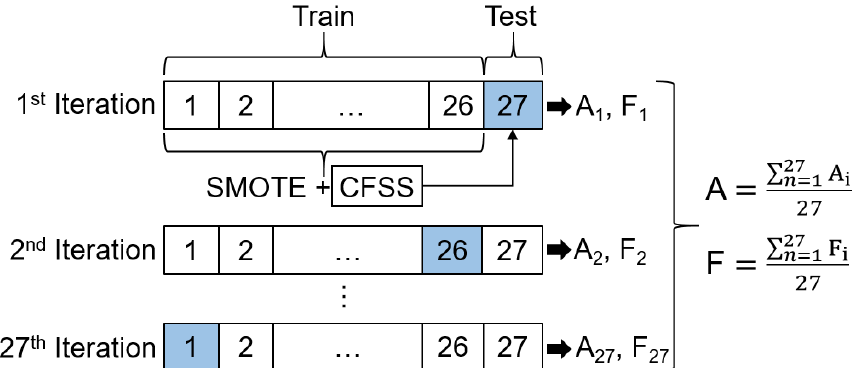
Figure 5. Graphic representation of Leave-One-Subject-Out Cross-Validation (LOSOCV) for 27 subjects: Oversampling of minority class in training set in each iteration with Synthetic Minority Oversampling Technique (SMOTE); Selection of best feature subset with Correlation-based Feature Subset Selection (CFSS) in training set and adjusting of features in testing set; calculation of average accuracy (A) and F-measure (F) (separately for both classes) across all